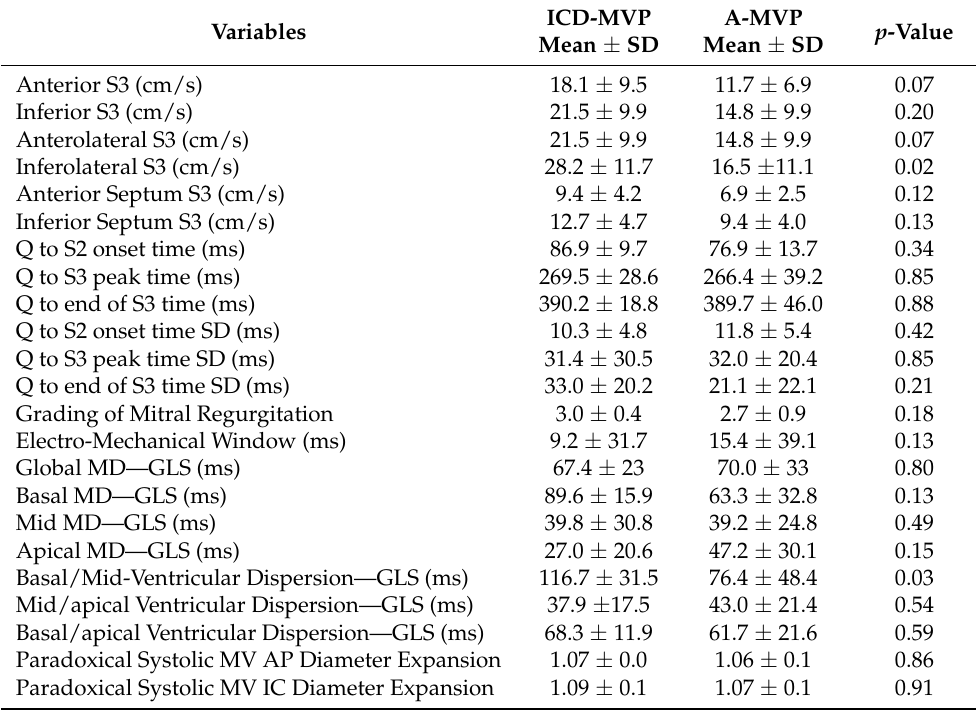
Table 3. Functional parameters comparison between ICD-MVP group and A-MVP group.